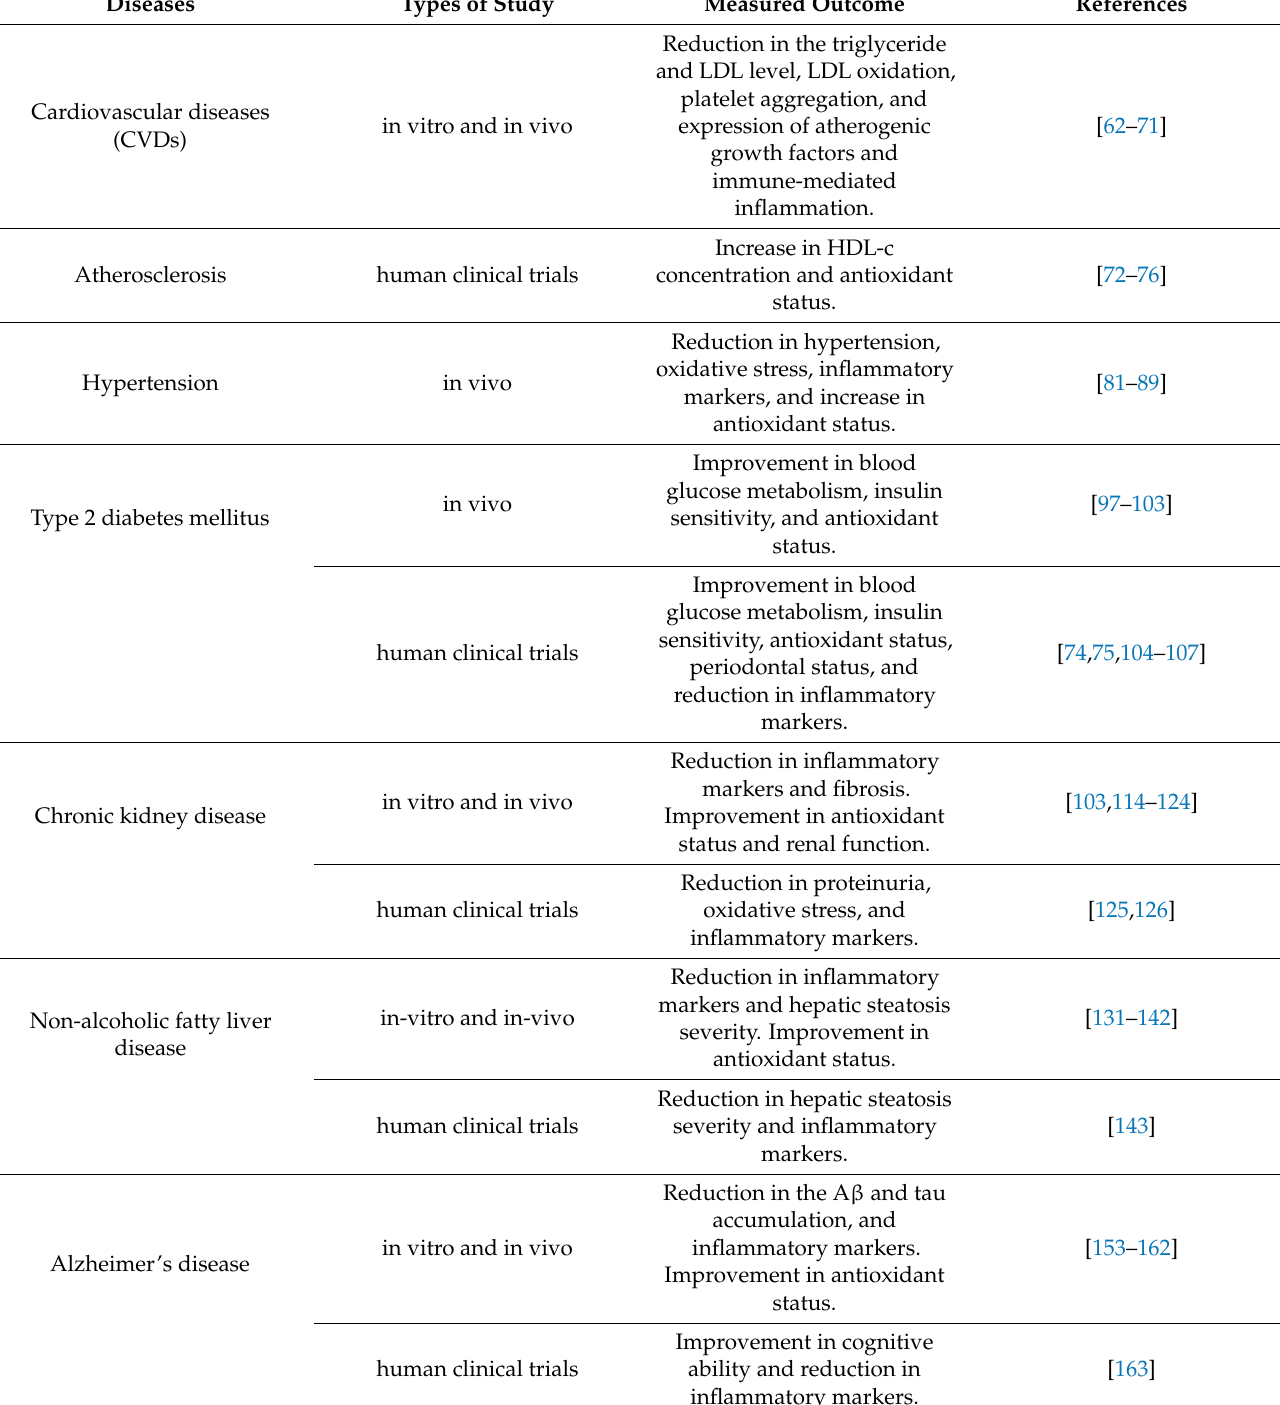
Table 1. Summary of various in vitro, in vivo, and human clinical trials with regard to the therapeutic uses of propolis in MetS and its associated chronic